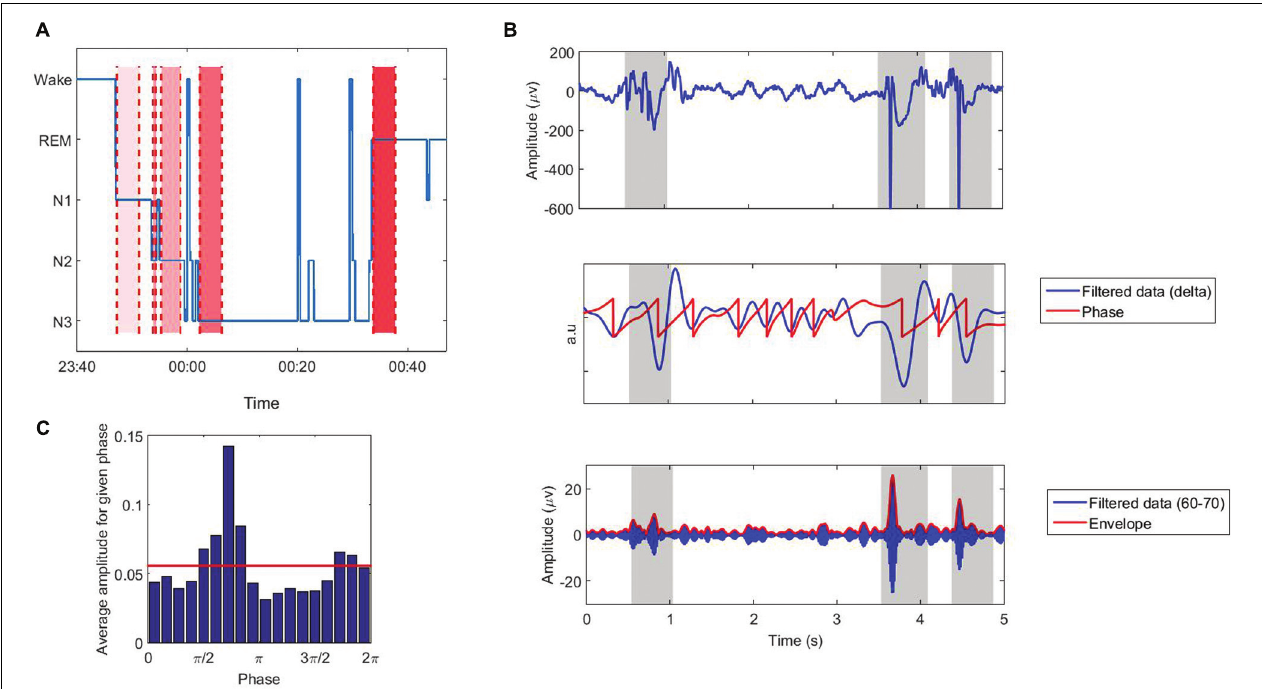
FIGURE 1 | (A) The first sleep cycle of the hypnogram (blue line), and data selection in different sleep stages in pt. 12 as an example: N1, N2, N3, and REM: from light to dark red regions. (B) Extracting phase and amplitude of the signal using Hilbert transform. Shading represents intervals of sharp activities that are removed from the analysis. (C) Average amplitude for a given phase for the signal shown in ‘ B ’. Red line shows the uniform